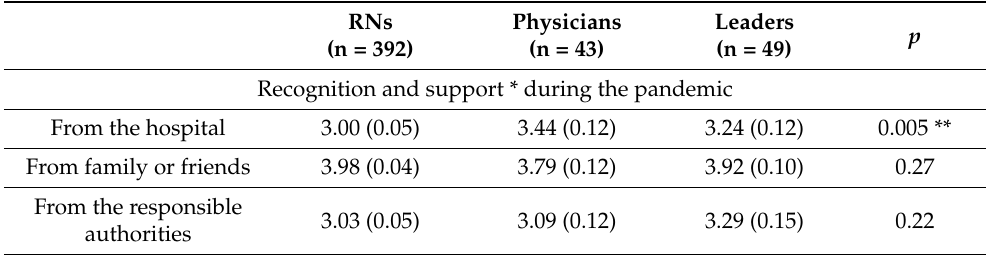
Table 5. Perceived recognition and support during the pandemic in health care professionals (mean [SD], N = 484). RNs Physicians Leaders p (n = 392) (n = 43) (n = 49) Recognition and support * during the pandemic From the hospital 3.00 (0.05) 3.44 (0.12) 0.005 ** From family or friends 3.98 (0.04) 3.79 (0.12) 0.27 From the responsible 3.03 authorities